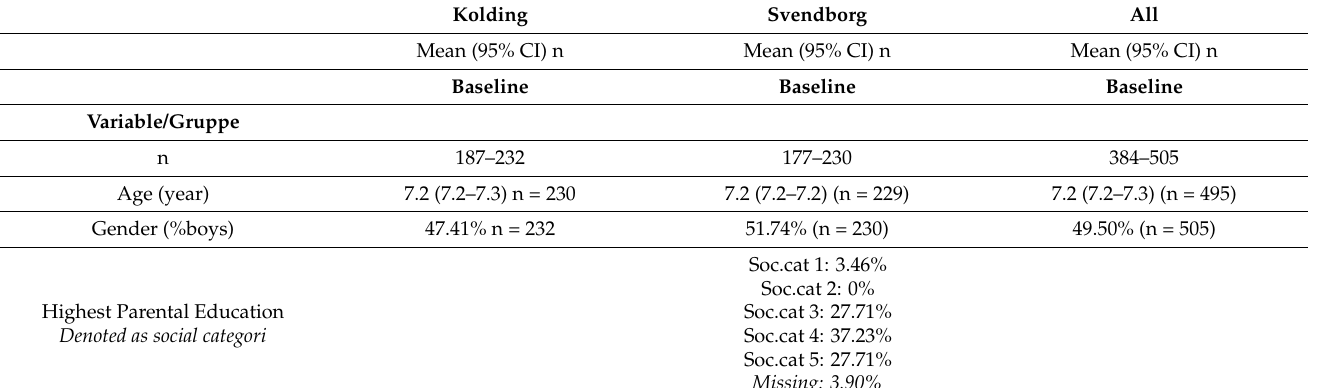
Table 1. Demographic Data. Baseline data. Study Population. Data is presented as mean (CI) for normal distributed data and by medians and 25% and 75% centiles for non-normally distributed